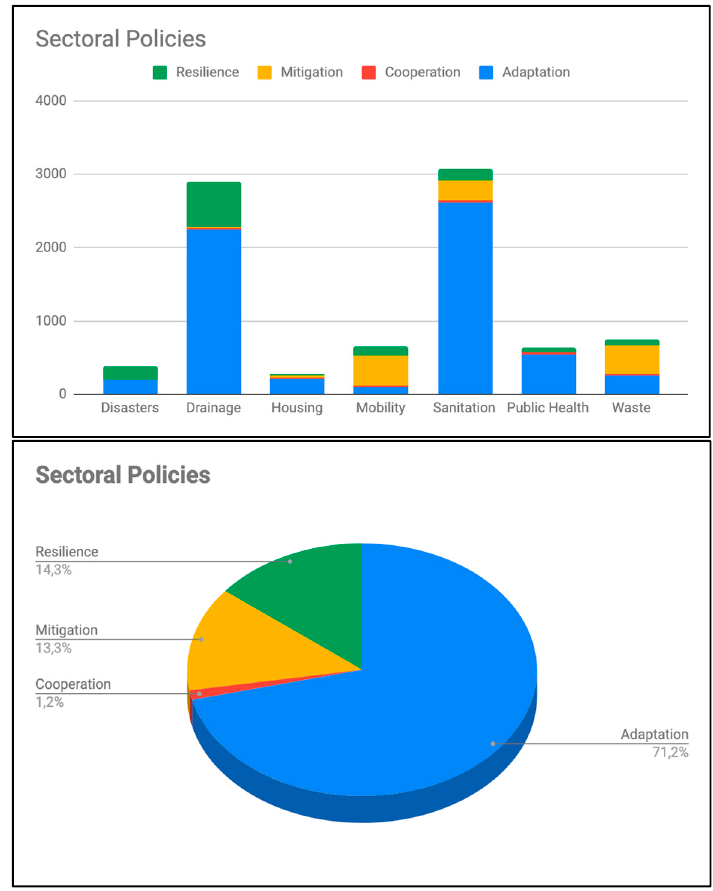
Figure 16. Climate action references in sectoral policies.